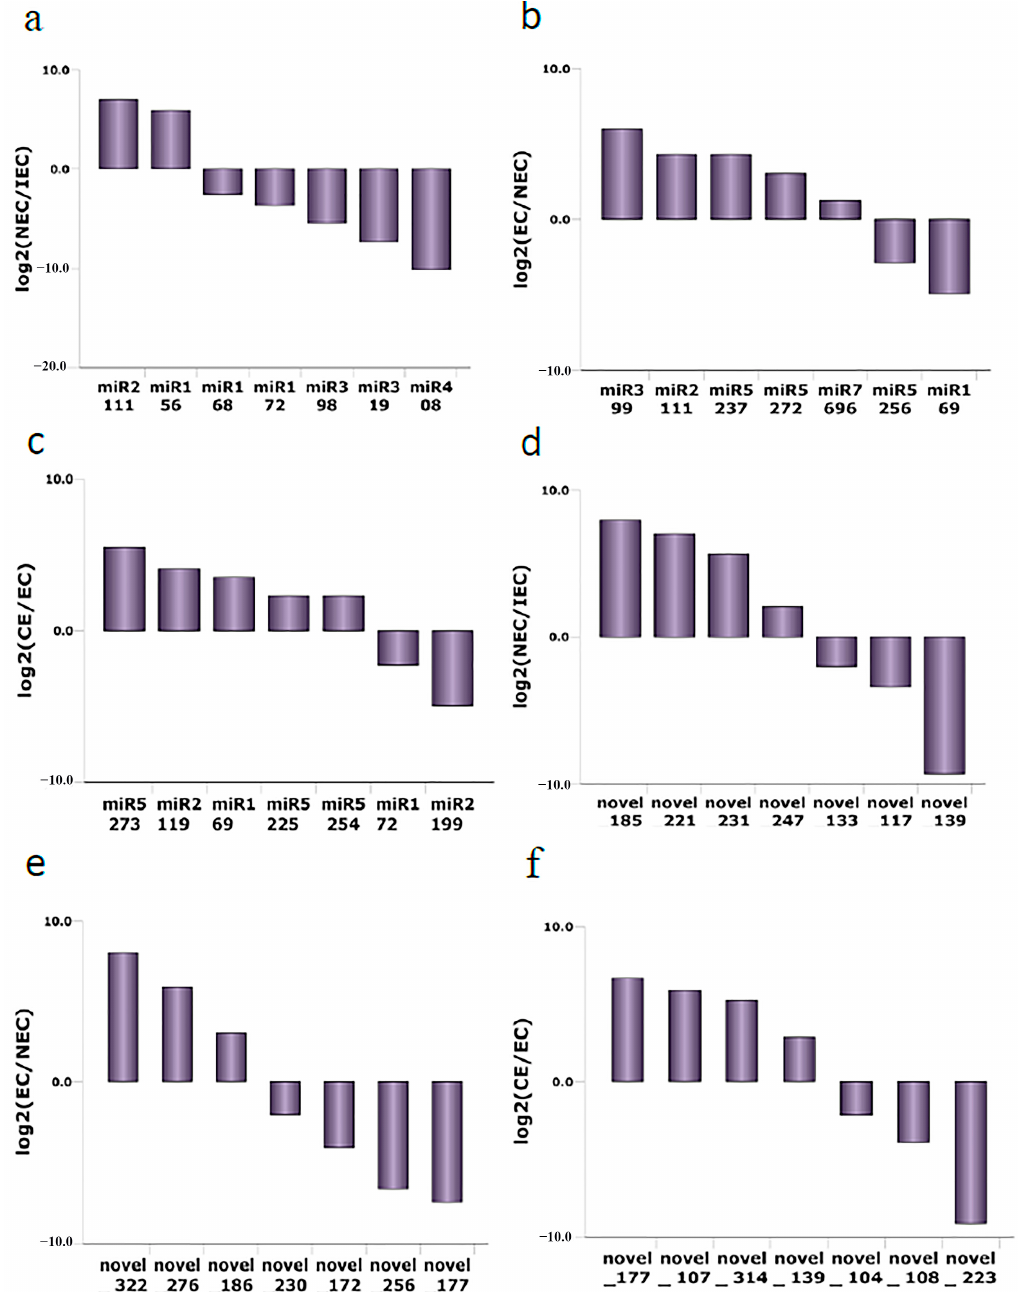
Figure 8. Differentially expressed known and novel miRNAs in M. sativa SE. ( a – c ) comparison of diferentially known miRNA families among ICE to NEC, NEC to EC and EC to CE; ( d – f ) comparison of diferentially novel miRNA families among ICE to NEC, NEC to EC and EC to CE. | log2FC | ≥ 2.